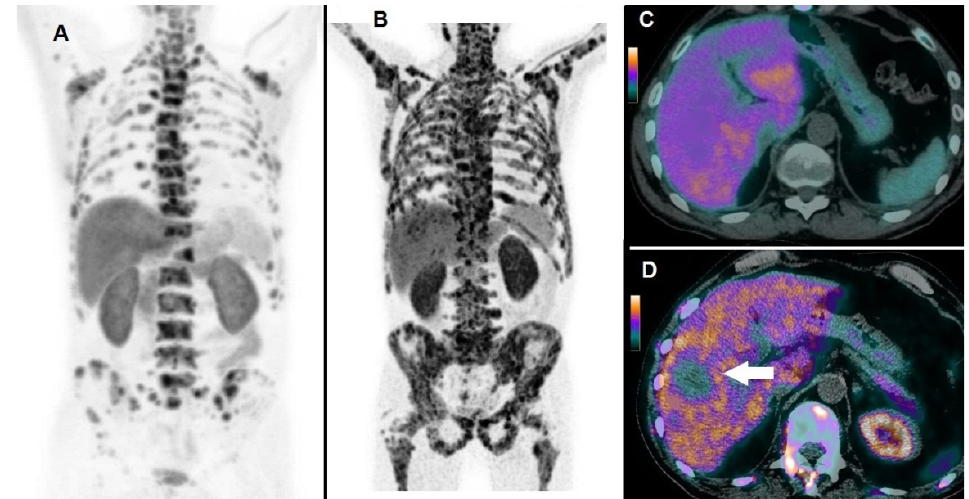
Figure 5. A 66-year-old patient affected by mCRPC, previously treated with abiraterone acetate and docetaxel, then submitted to 223 Ra-therapy. 18 F-choline PET/CT acquired at baseline demonstrated multiple tracer uptake sites in bones, as evident in Whole Body ( A ); baseline pre-treatment parameters were as follows: PSA = 157 ng/mL; the number of lesions > 20; TLA = 3969.9 g. After 3 cycles, 223 Ra-therapy was discontinued due to deterioration of patient’s performance status and increased PSA (i.e., 289 ng/mL). 18 F-choline PET/CT acquired after 3 cycles of 223 Ra-therapy demonstrated an impressive progression of skeletal disease, as shown by Whole Body ( B ). 18 F-choline PET / CT fused images of the liver acquired at baseline did not show abnormal tracer uptake ( C ), while post-treatment axial slices demonstrated the appearance of a partially necrotic metastasis in the VIII / VII